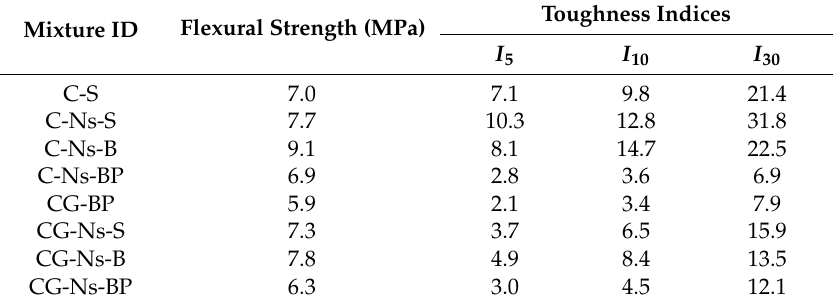
Table 5. Results of flexural strength and toughness